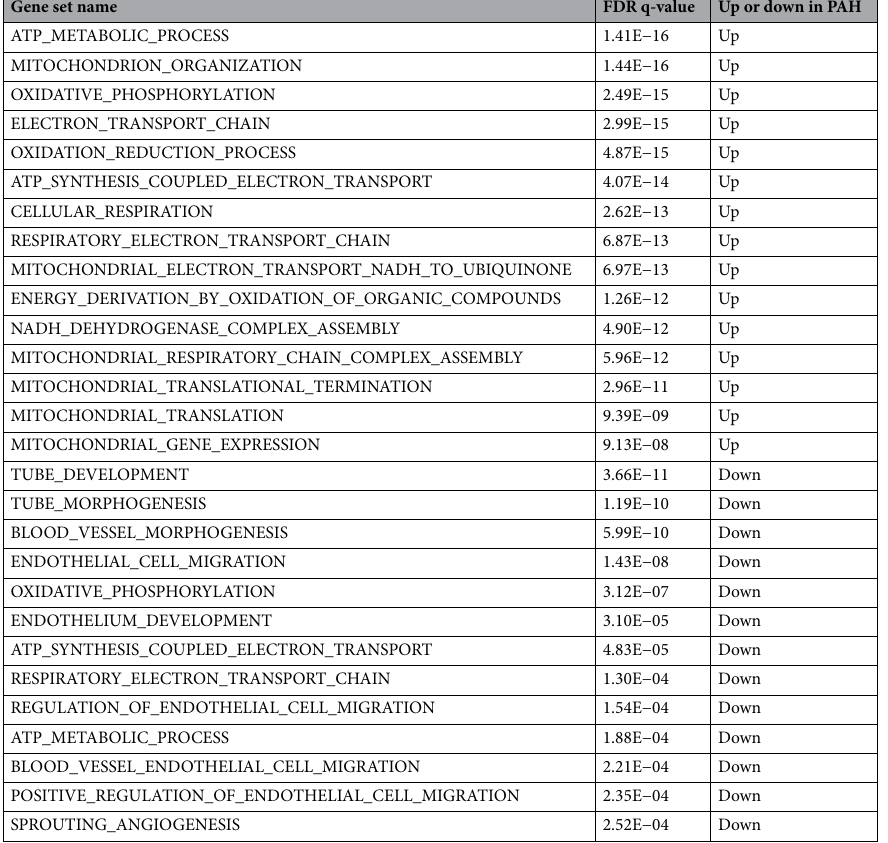
Table 1. Differential expression of endothelial and mitochondrial pathways by ontology analysis. FDR false discovery